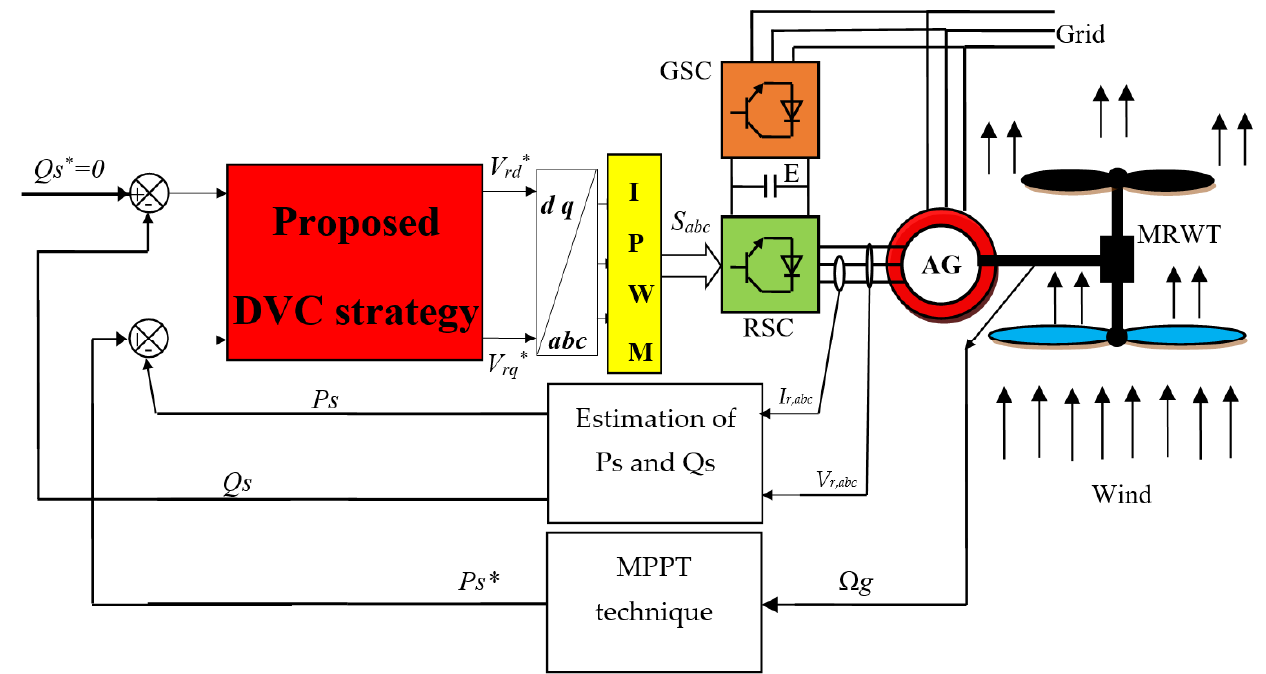
Figure 13. Proposed DVC control of the AG-MRWT system.